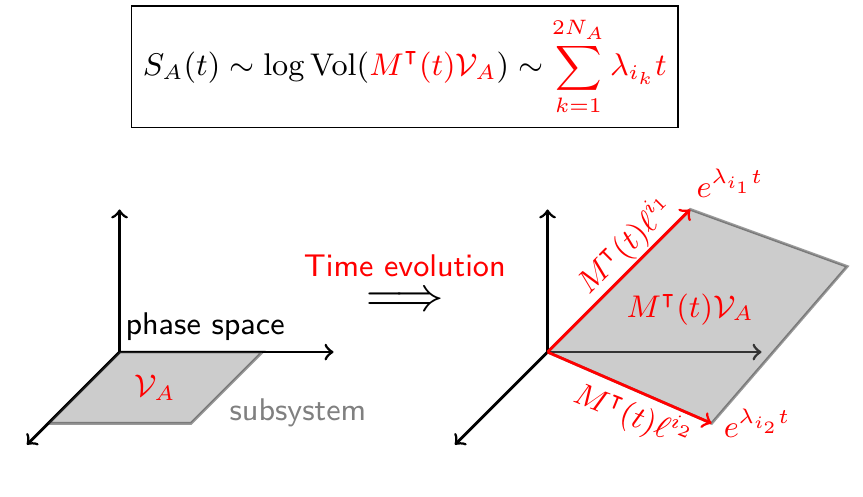
Figure 9 . Subsystem exponents due to phase space stretching . We illustrate the statement of theorem 3. We start with a symplectic cube V A (cid:26) A (cid:3) in the subsystem and time-evolve it to the deformed cube M | ( t ) V A that is dominantly stretched into the 2 N A directions of M | ( t ) ‘ i k with Lyapunov exponents (cid:21) i k